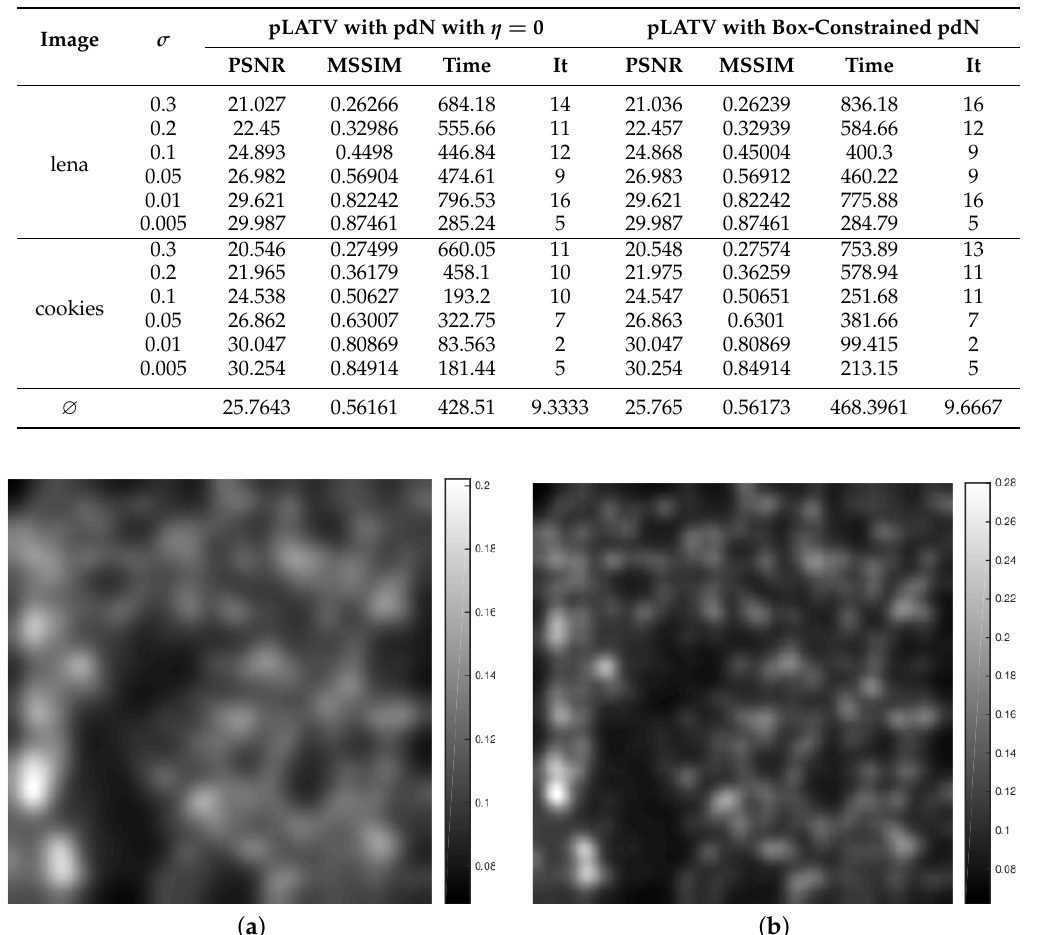
Figure 11. Spatially varying regularization parameter generated by the respective pLATV-algorithm. ( a ) pLATV with pdN with η = 0; ( b ) pLATV-algorithm with box-constrained pdN.